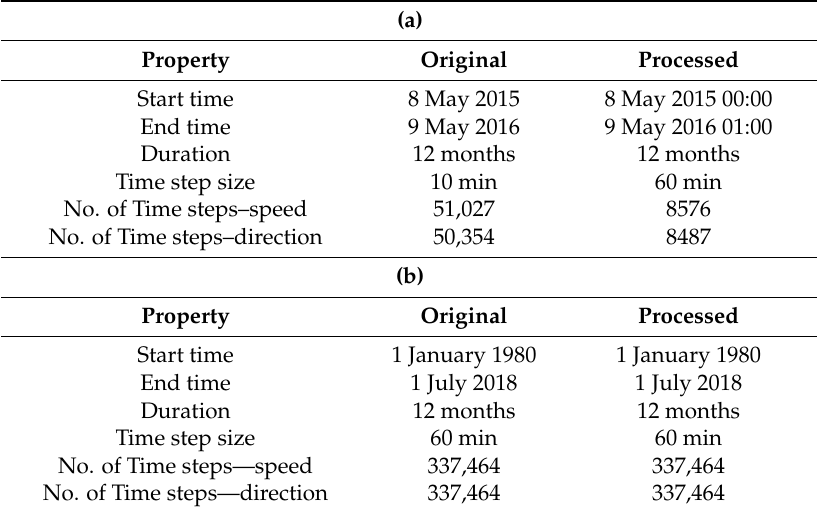
Table 4. Properties of (a) target data and (b) reference